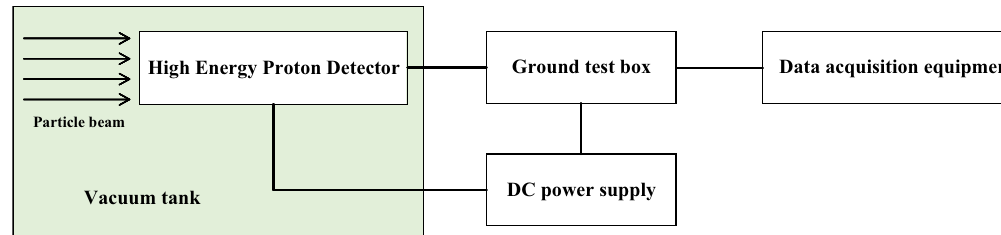
Figure 8: Block diagram of the energy calibration